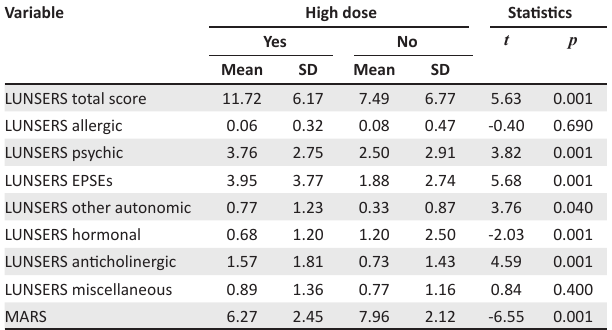
TABLE 5: Comparison of Liverpool University neuroleptic side effects rating scale and medication adherence rating scale scores of participants and ‘high dose’ prescribing. Variable High dose Statistics